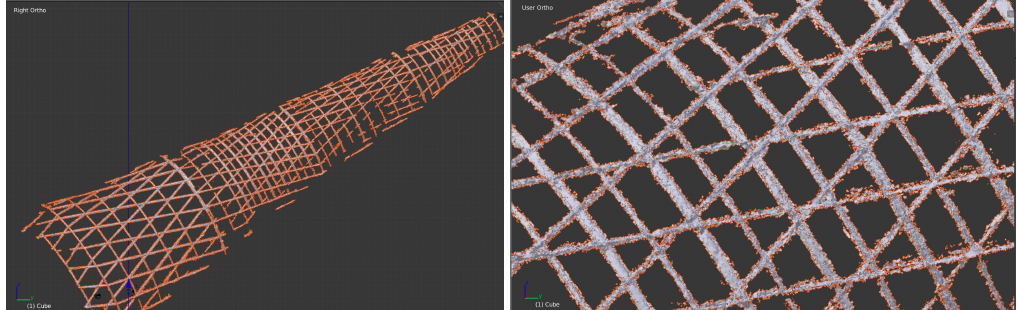
Figure 12. One of the ’stripes’ processed with proposed technique: left —whole ’stripe’ processing, right —a fragment of surface 3D